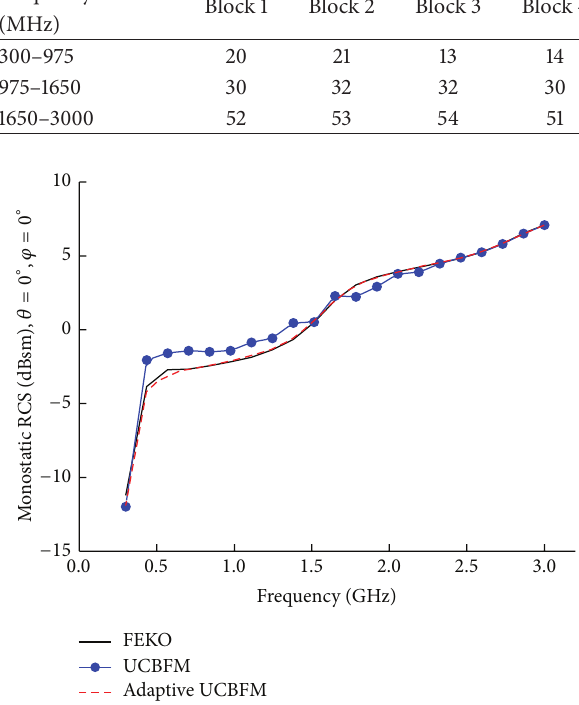
Figure 1: Broadband monostatic RCS of PEC plate.